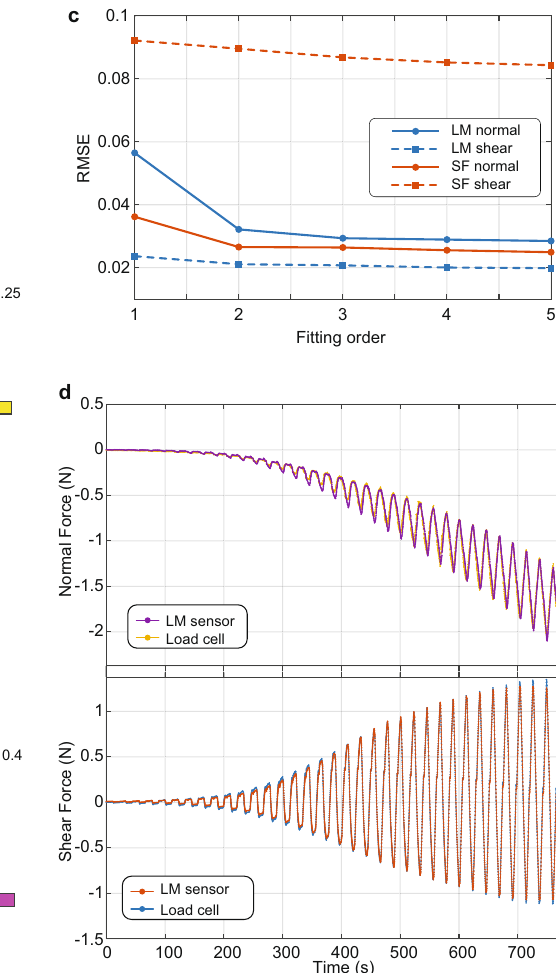
Fig.6|Force-capacitanceconversionandcomparisonbetweentheliquidmetal sensor and the load cell. a The measured normal force is plotted as a function of measuredcapacitancechanges, Δ C 1 and Δ C 2 .Asurfaceis fi tted tothisdata.The 3D plotshowstheexperimentaldata(blackdots)andthesurface fi twithsecondorder ( n =2).Thesurface fi tallowsustoextractthecoef fi cientsforthecapacitance – force conversion, and, therefore to formulate the normal force as a function of Δ C 1 and